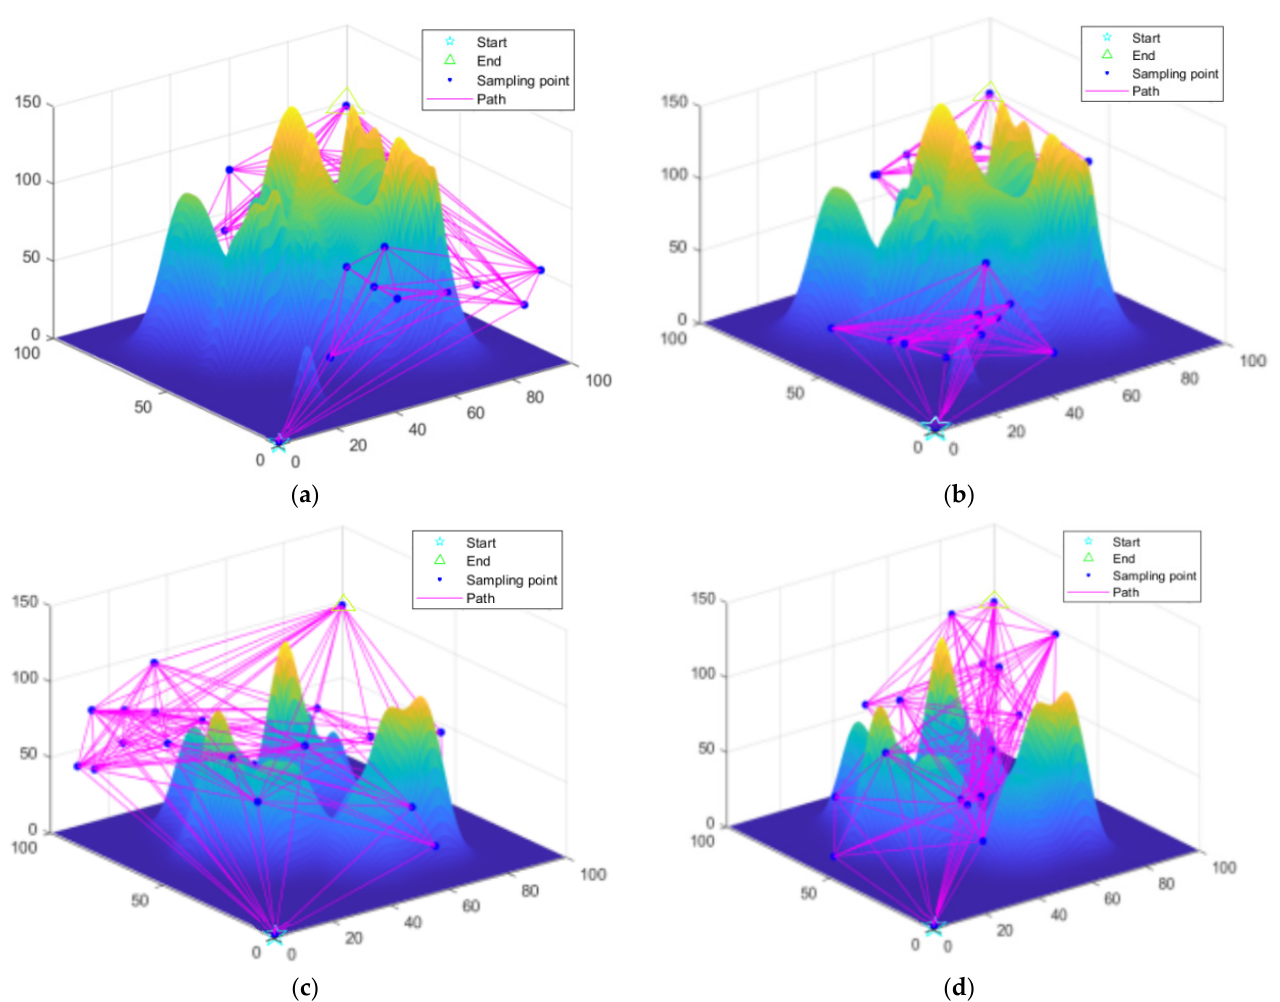
Figure 13. Planning results under different obstacles: ( a ) PRM on 40 peaks; ( b ) IPRM on 40 peaks; ( c ) PRM on 20 peaks; ( d ) IPRM on 20 peaks.